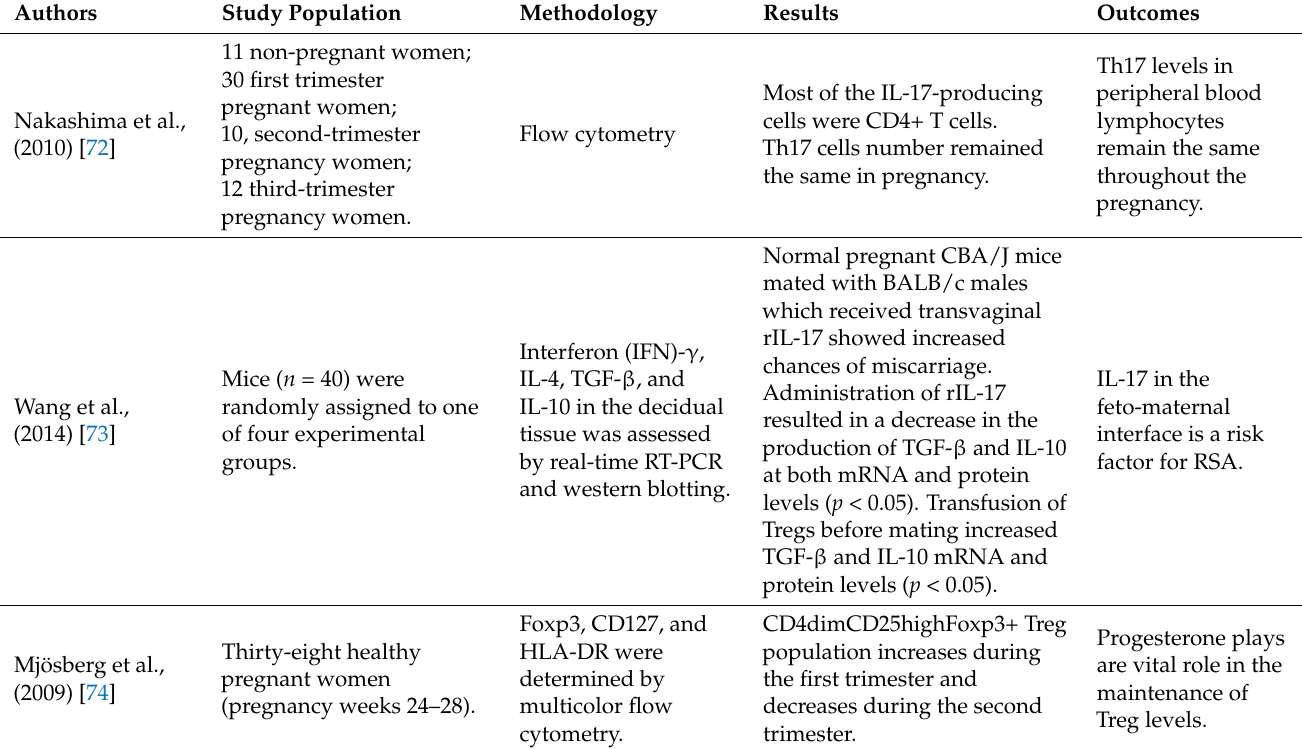
Table 2. T-cells and their role in pregnancy and